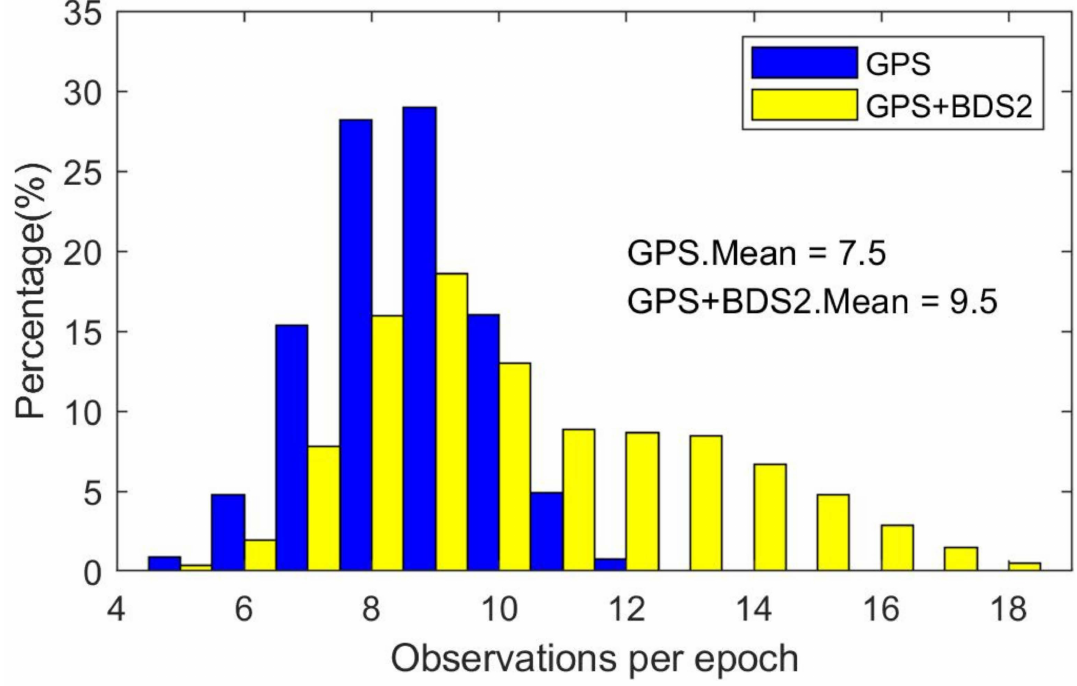
Figure 12. Visible navigation satellites from TH-2A and TH-2B.